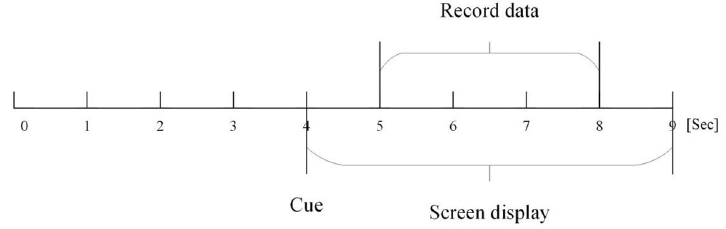
Figure 1. The collection process of an